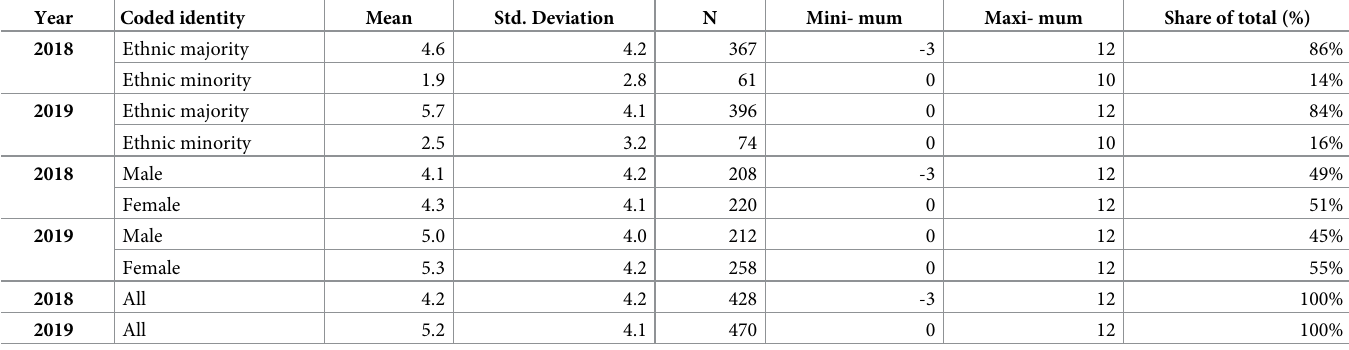
Table 1. Summary